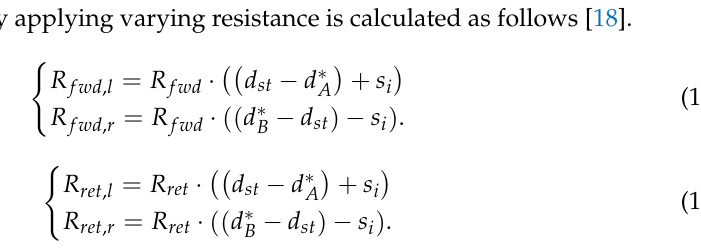
Figure 5. Schematics of moving train load using varying